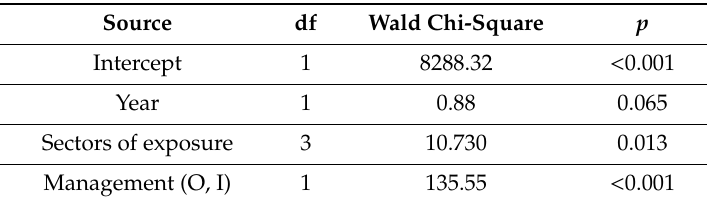
Table 4. Generalized linear model (GLM) evaluating the e ff ects of di ff erent variables on the dropped drupes (2018–2019: n = 192). Source df Wald Chi-Square p Intercept 1 8288.32 < 0.001 0.88 0.065 Sectors of exposure 3 10.730 0.013 Management (O, I) 1 135.55 < 0.001 Sectors of exposure ( n = 4): NE, SE, SW, and